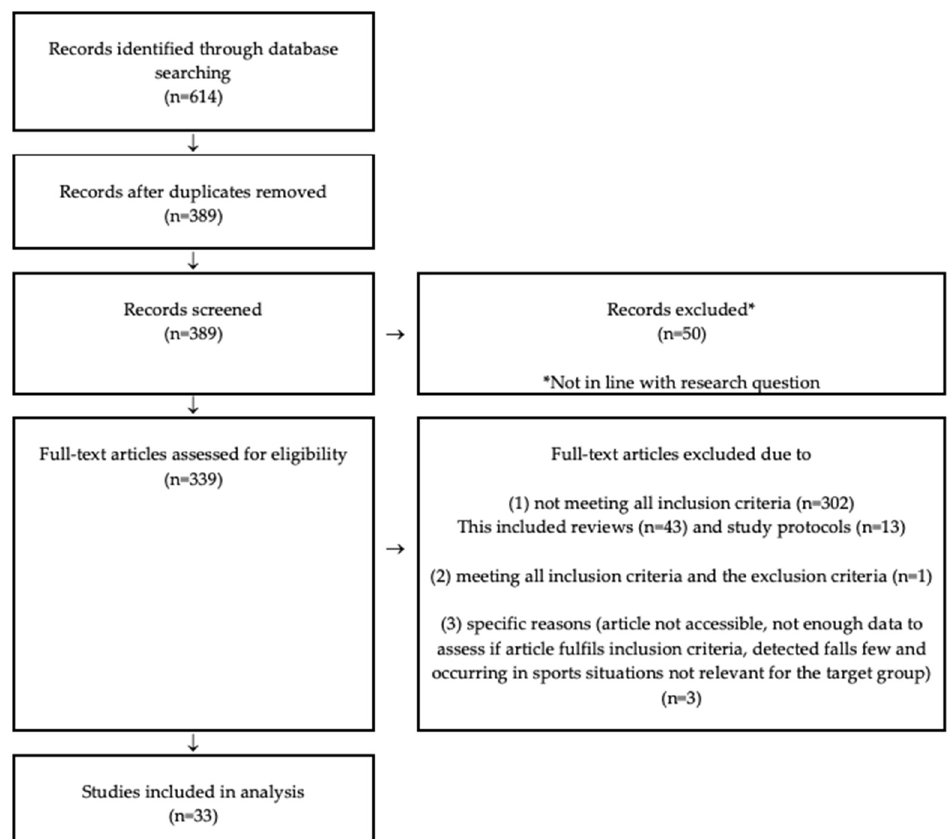
Figure 1. Flow diagram of articles identified and evaluated based on eligibility criteria.